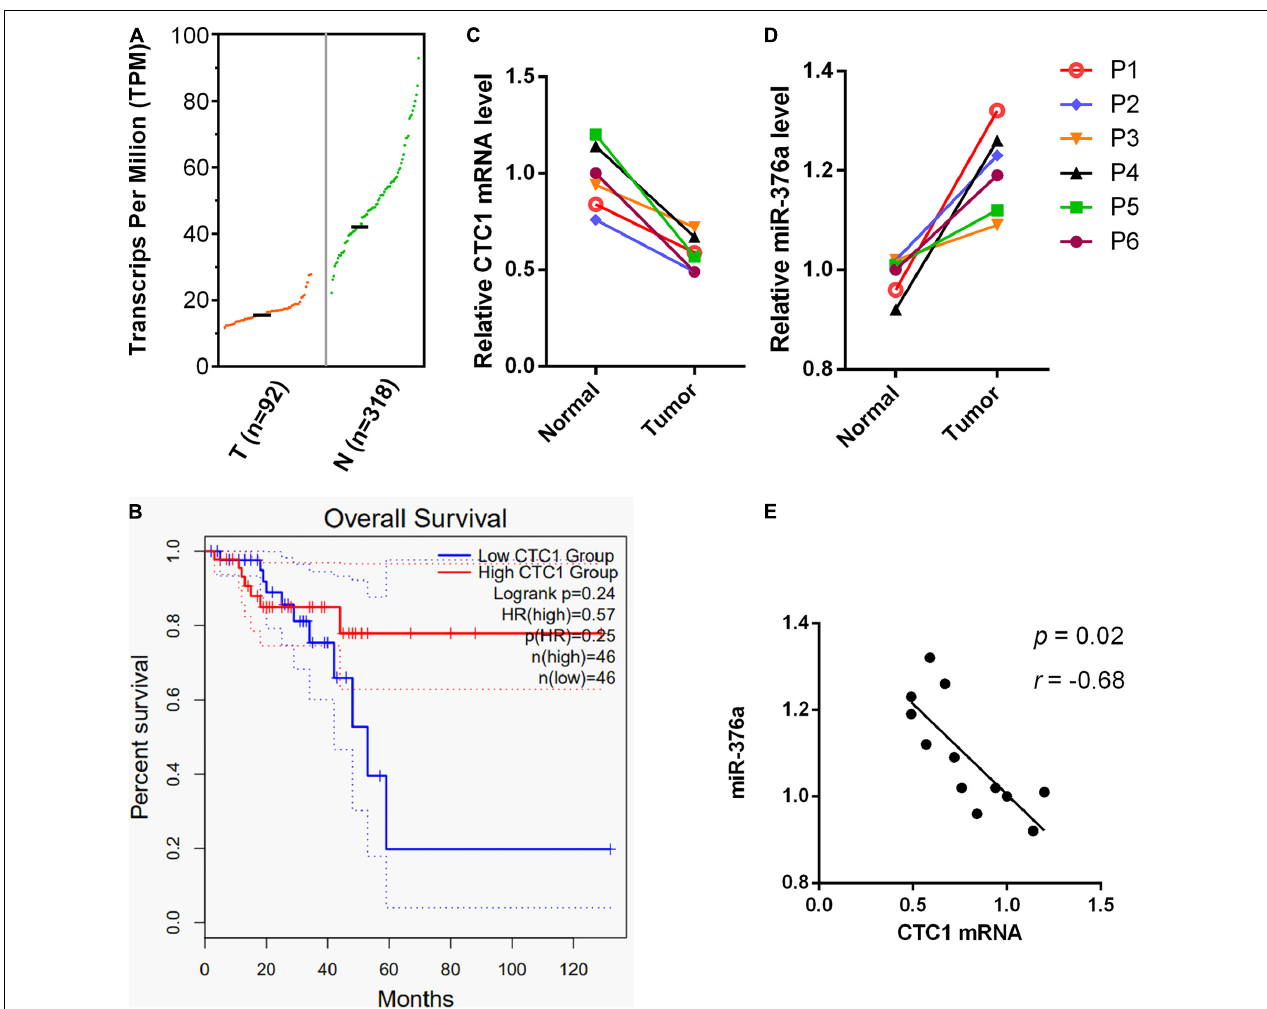
FIGURE 6 | miR-376a expression is correlated with CTC1 deregulation and poor outcomes in rectum adenocarcinoma patients. (A) The CTC1 messenger RNA (mRNA) transcription in rectum adenocarcinoma tumor and normal tissues was analyzed. The mRNA transcriptional data was obtained from the GEPIA2 database, with 92 tumor and 318 normal samples included. (B) The overall survival rates of rectum adenocarcinoma patients with high or low levels of CTC1 were demonstrated based on the 92 tumor patients from the GEPIA2 database. (C,D) The mRNA samples of tumor tissue and adjacent tissues from six rectum adenocarcinoma patients were obtained. The transcriptional levels of CTC1 and miR-376a were determined by quantitative real-time PCR. (E) The inverse relation between CTC1 and miR-376a was also observed based on the transcriptional levels of the 12 samples from the tumor and adjacent tissues of the six rectum adenocarcinoma patients tested in our current